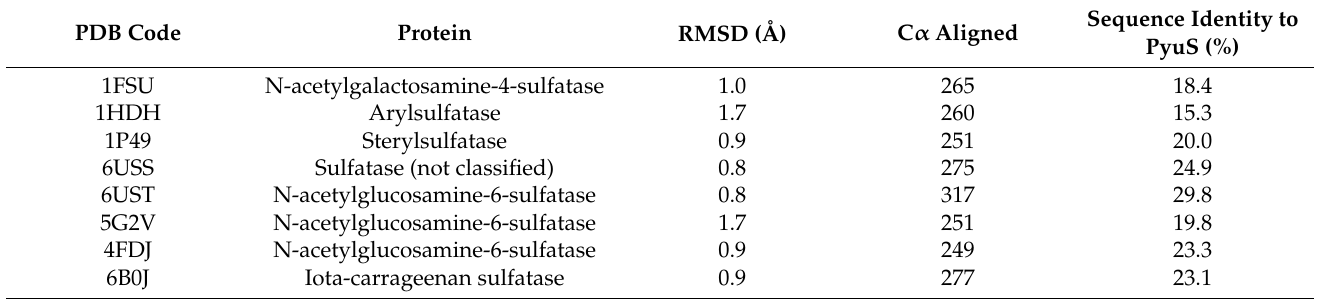
Table 1. Protein Data Bank (PDB) sulfatase structures homologous to PyuS. RMSD is the root mean square deviation from C α alignment; C α is the number of alpha carbons aligned; and sequence identity refers to primary amino acid sequence alignment. RMSD values were calculated by aligning C α in PyMOL [31]. Sequence identity was calculated with CLUSTAL W [39]. Signal peptides or putative signal peptides were removed for all